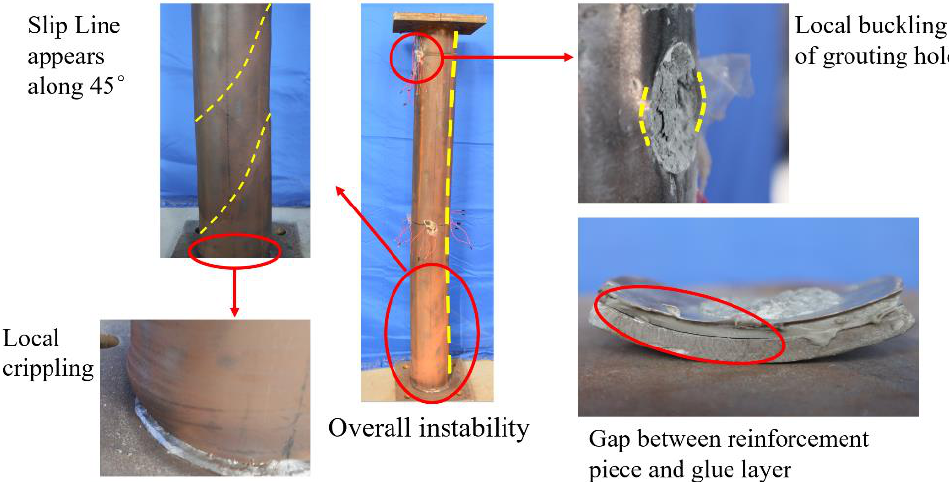
Figure 11. Typical failure mode in descending branch of load-displacement curves.